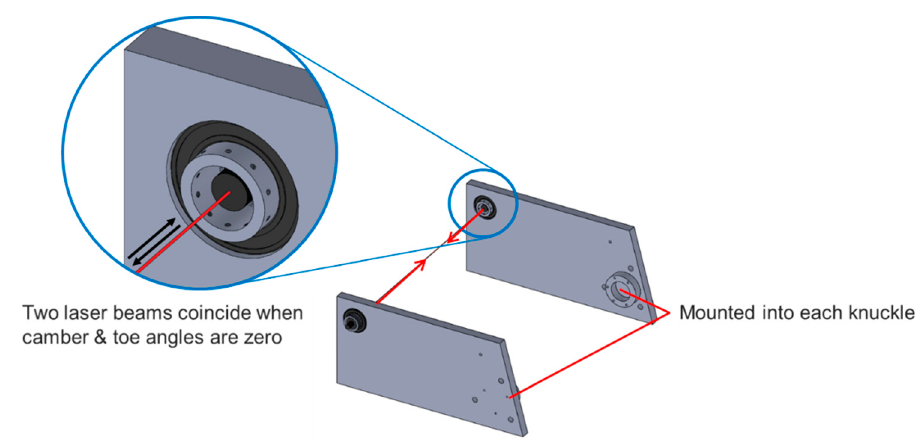
Figure 5. Wheel knuckle and mounted jig.